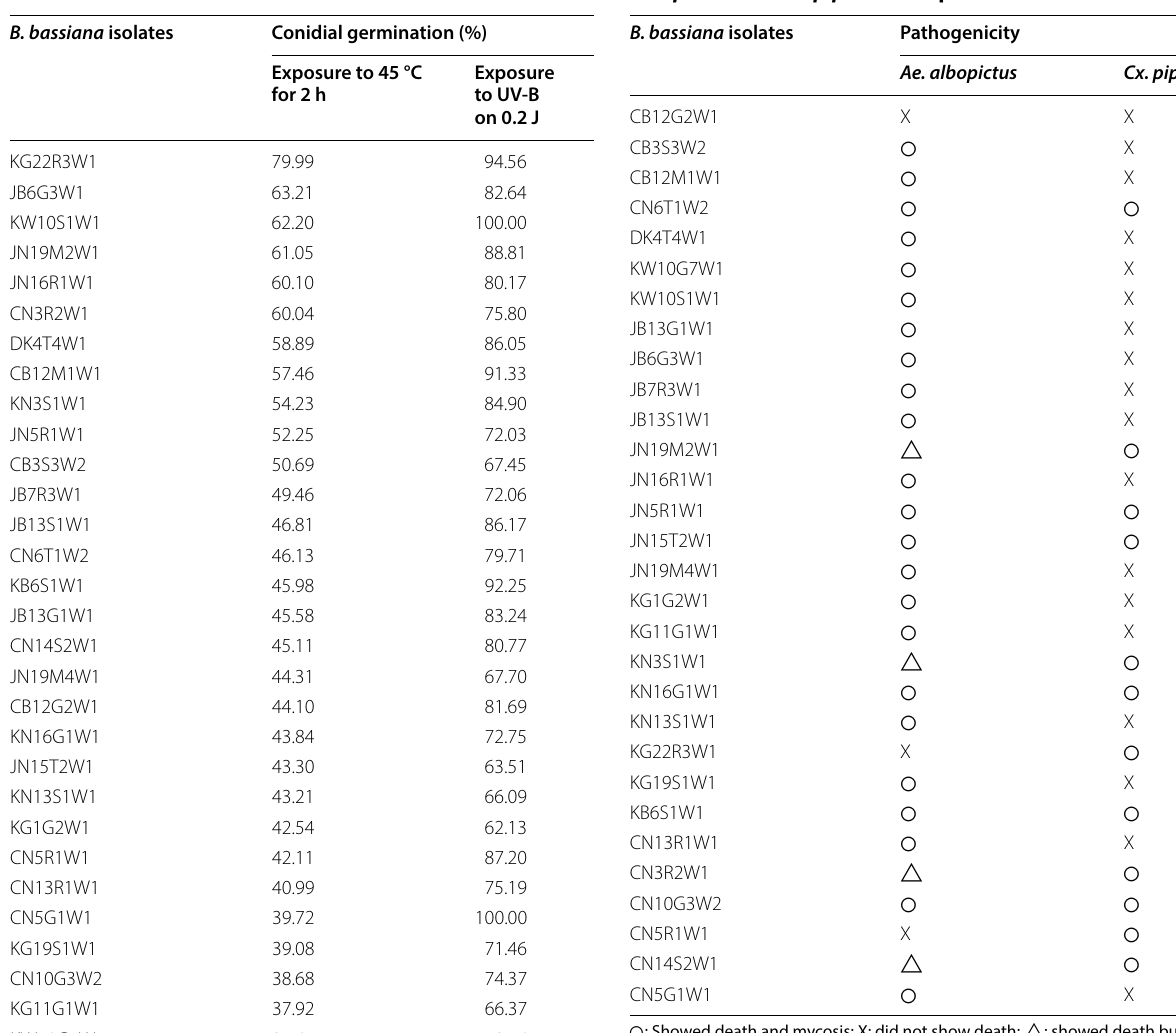
Table 1 Thermotolerance and UV-B tolerance of B. Table 2 Pathogenicity of B. bassiana isolates against